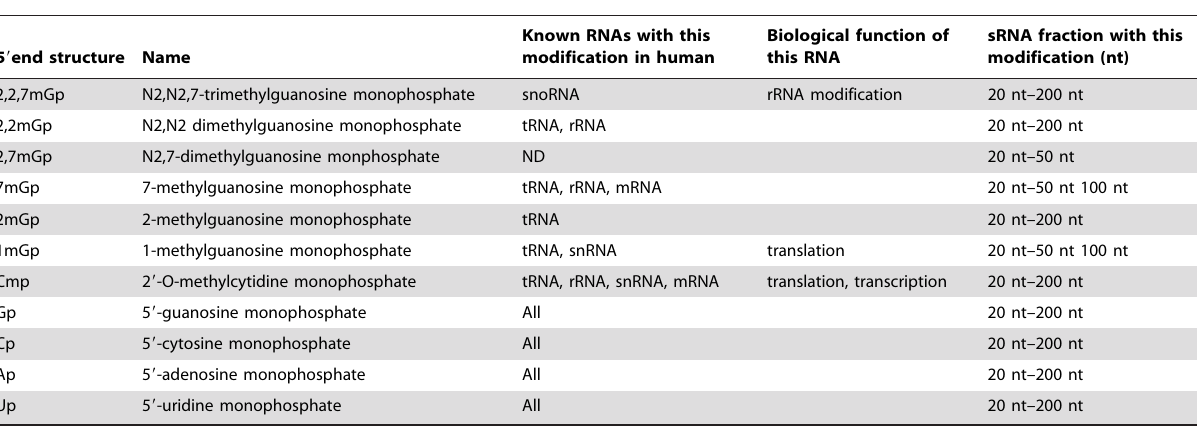
Table 2. Summary of cap structures that were cross-validated by 2D-TLC and mass